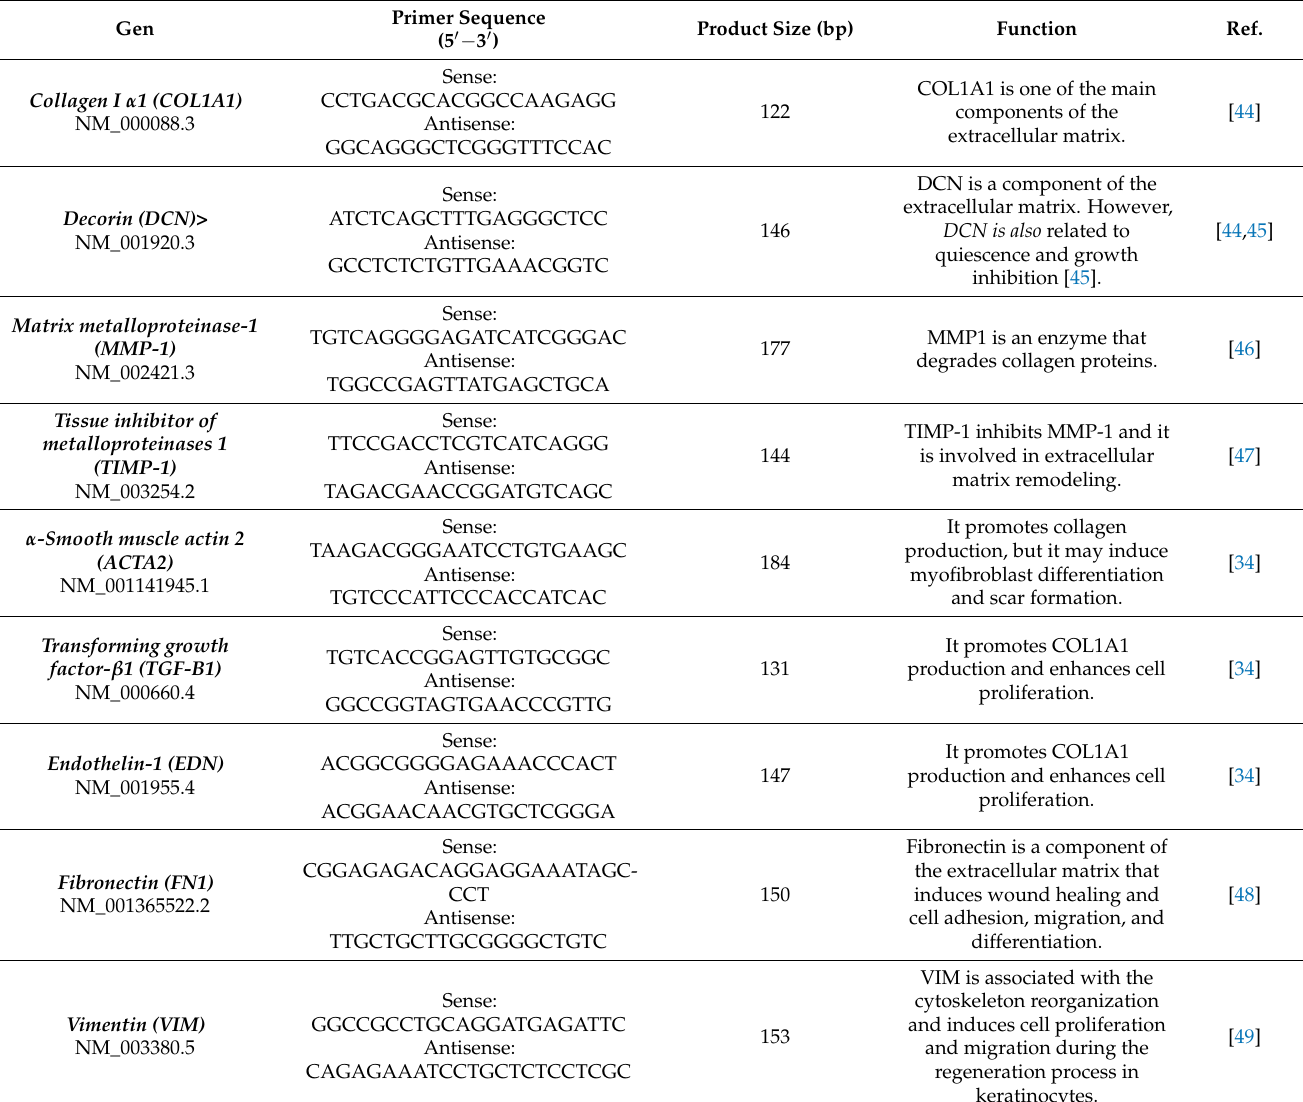
Table 1. Genes and their sense (S) and antisense (A) primer sequences used in the real-time